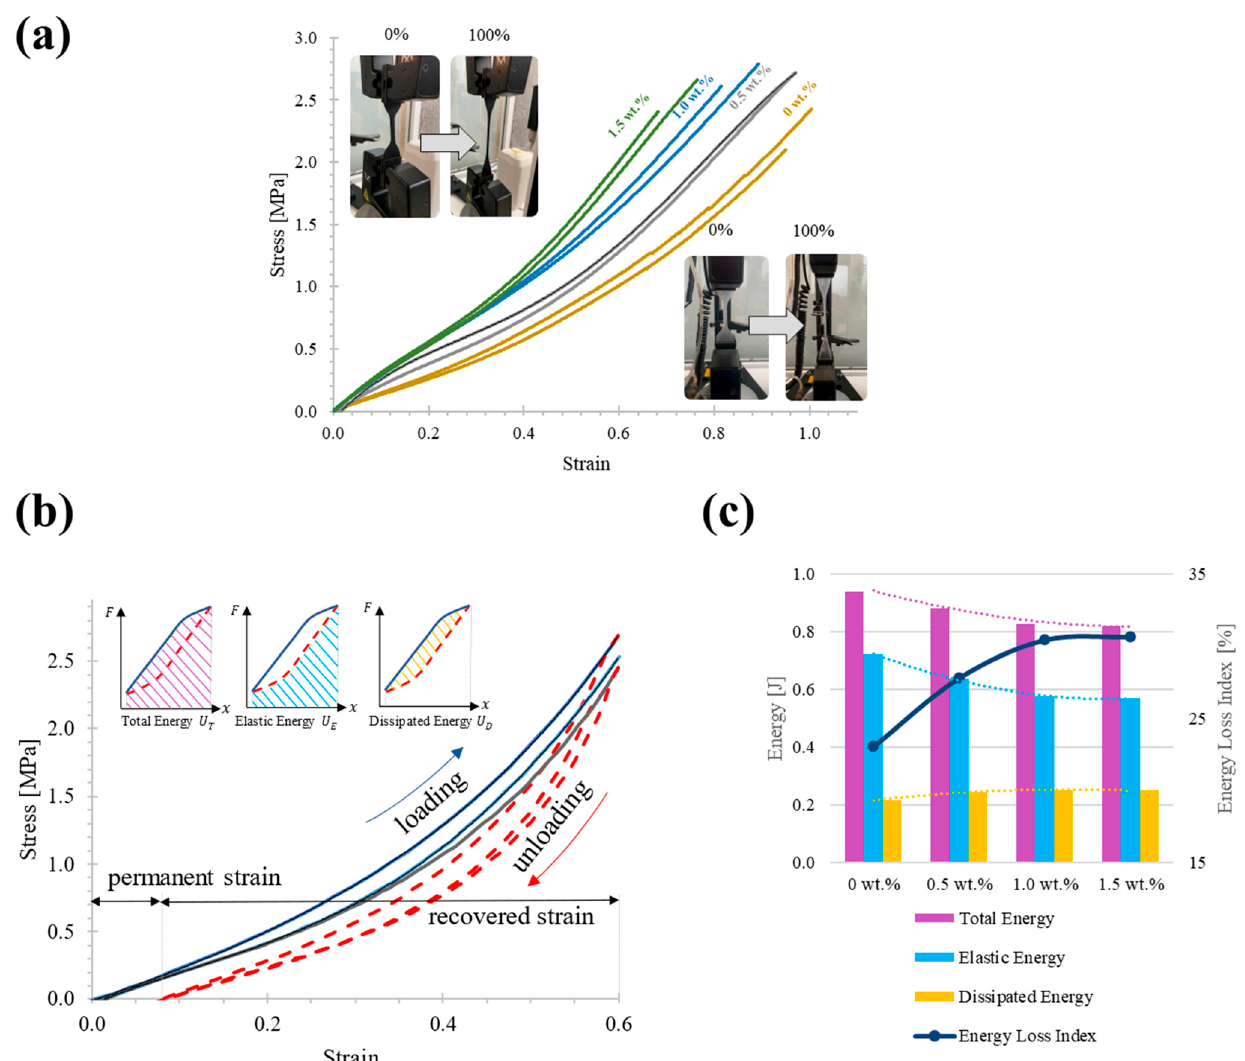
Figure 6. Experimental data for ( a ) Uniaxial static test until failure of the four types of specimens with different percentages of filler composition for 1.5 wt.% (green), 1.0 wt.% (blue), 0.5 wt.% (gray), 0 wt.% (olive); ( b ) Loading–unloading test showing the hysteresis behavior during nonlinear elastic deformation, as well as the permanent strain present in the nanocomposite material (continuous lines are during loading and dashed lines are during unloading); ( c ) Trend graph of the calculation of the three types of energy presented during the cyclic-to-cycle tests performed.